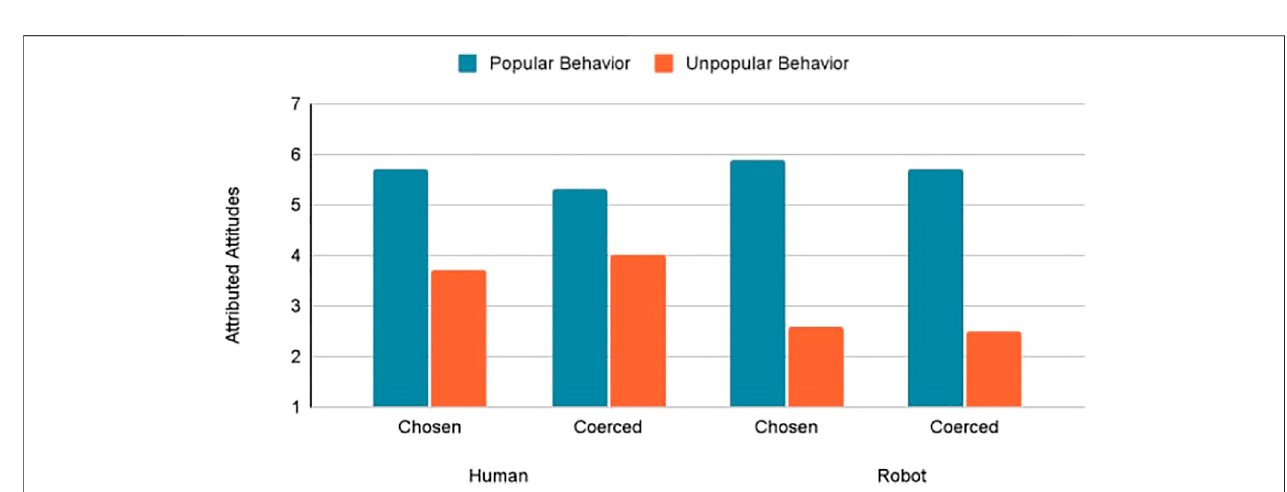
FIGURE 2 | Simple main effects of choice and behavior on attitudes attributed to agents.